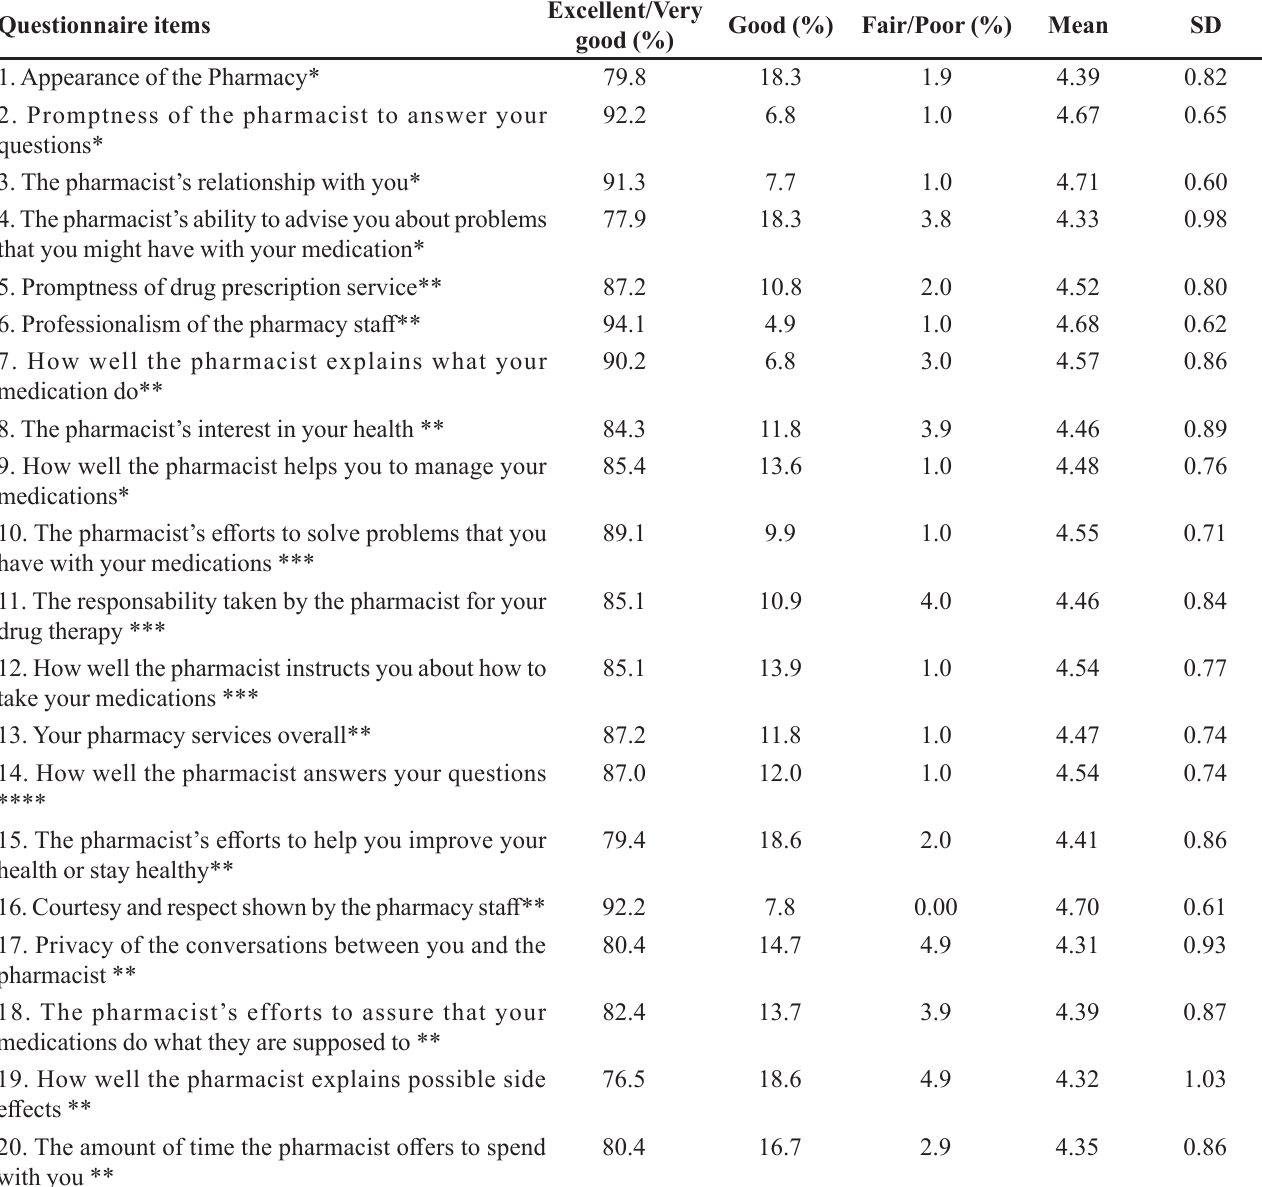
TABLE V – Patient satisfaction with the drug dispensing service at the University Pharmacy of the Federal University of Goias, 2013 Questionnaire